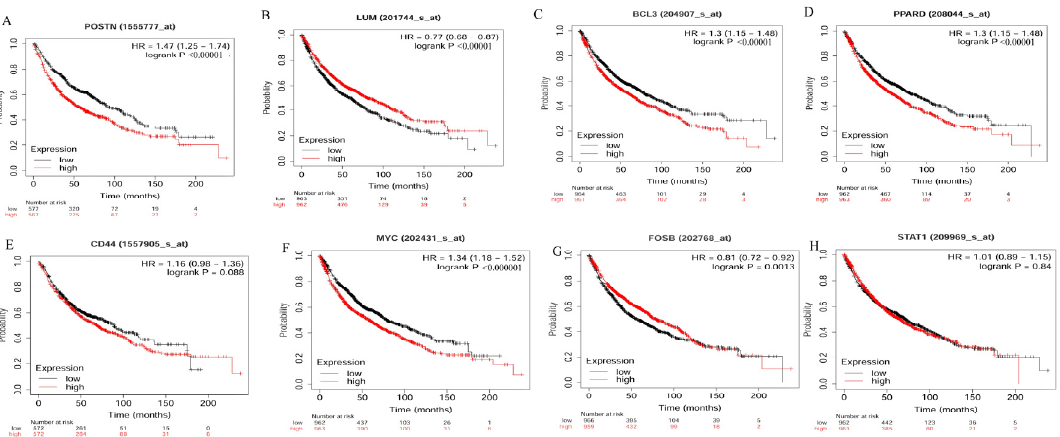
Figure 10. In vivo validation for the effect of eight genes on overall survival in lung cancer patients using KM Plot. ( A ) POSTN , ( B ) LUM , ( C ) BCL3 , ( D ) PPARD , ( E ) CD44 , ( F ) MYC , ( G ) FOSB , and ( H ) STAT1 . HR = Hazard